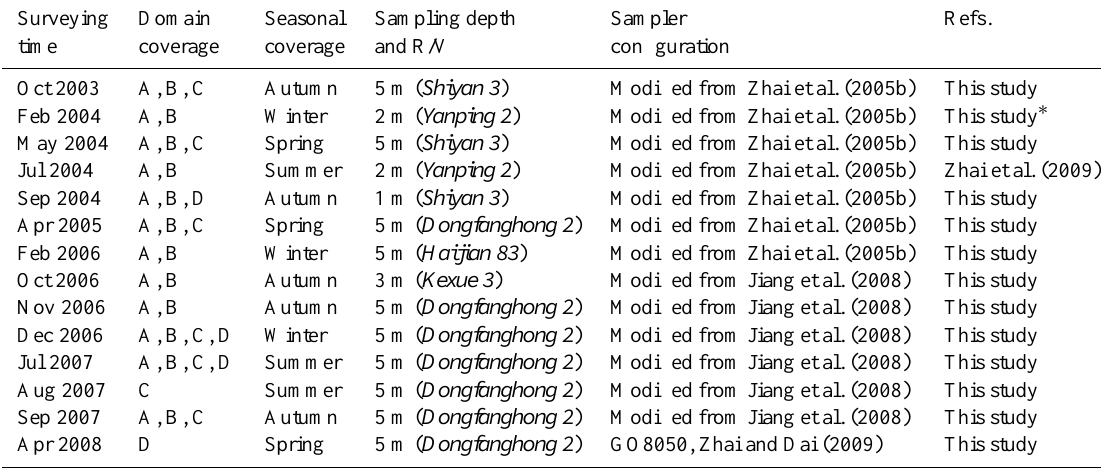
Table 2. Summary of the information of the sampling cruises between 2003 and 2008.